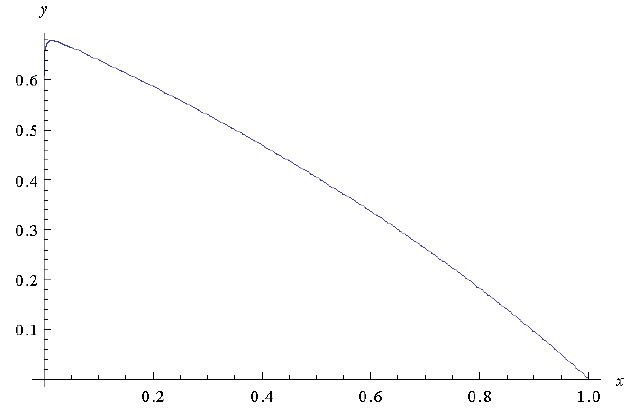
Figure 3. The approximate solution y for (cid:101) = 0.00001.